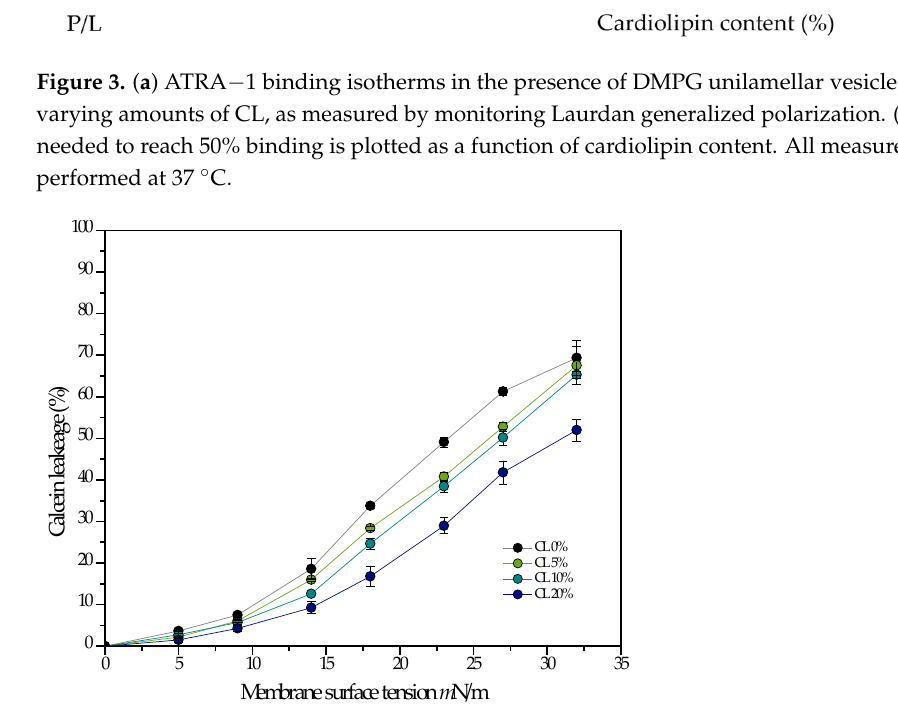
Figure 3. ( a ) ATRA − 1 binding isotherms in the presence of DMPG unilamellar vesicles containing varying amounts of CL, as measured by monitoring Laurdan generalized polarization. ( b ) P/L ratio needed to reach 50% binding is plotted as a function of cardiolipin content. All measurements were performed at 37 °C.